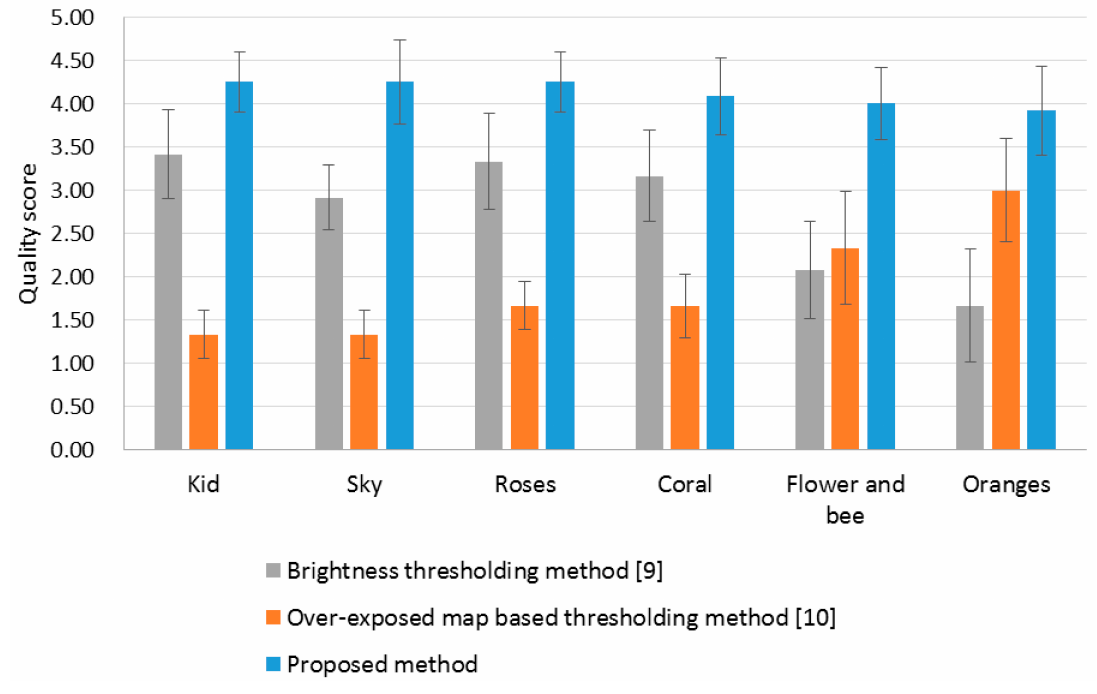
Figure 6. Subjective evaluation result for the OER detection